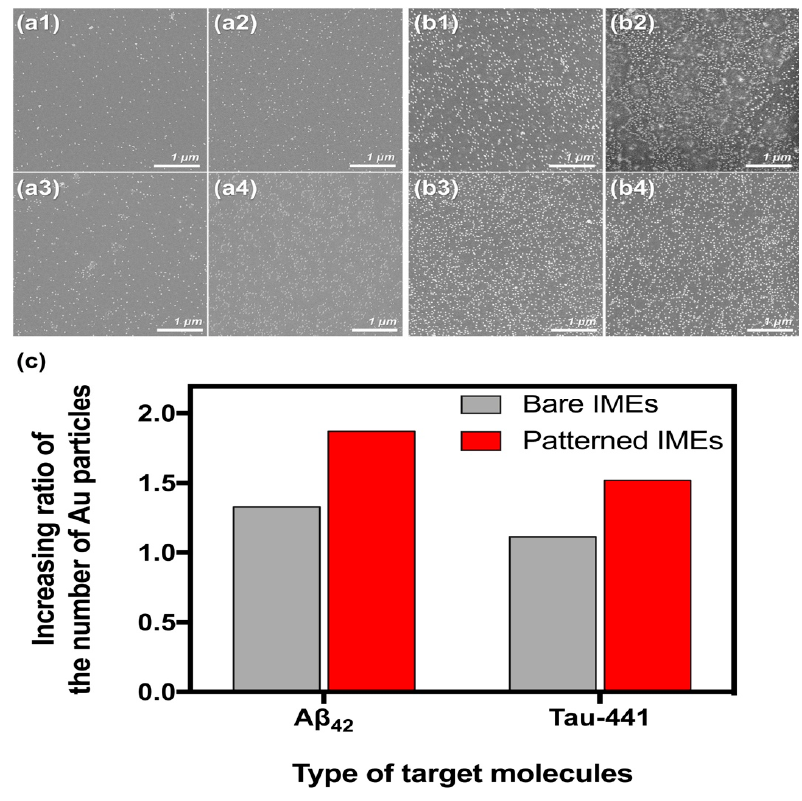
Figure 4. SEM images of the Au particles conjugated with secondary antibody on the surface of IMEs: Bare IMEs surfaces after sequential treatment with (6E10)–(A β 42 )–(12F4) at ‘Ref.’ and at optimal voltage (0.8 V pp ); with (tau-5)–(tau-441)–(7B8) at ‘Ref.’ and at optimal voltage (0.5 V pp ) ( a1–a4 , respectively); patterned IMEs surfaces after sequential treatment with (6E10)–(A β 42 )–(12F4) at ‘Ref.’ and at optimal voltage (0.9 V pp ); with (tau-5)–(tau-441)–(7B8) at ‘Ref.’ and at optimal voltage (0.6 V pp ) ( b1–b4 , respectively); ( c ) Increasing ratio of the number of Au particles by the DEP force in the bare and patterned IMEs.